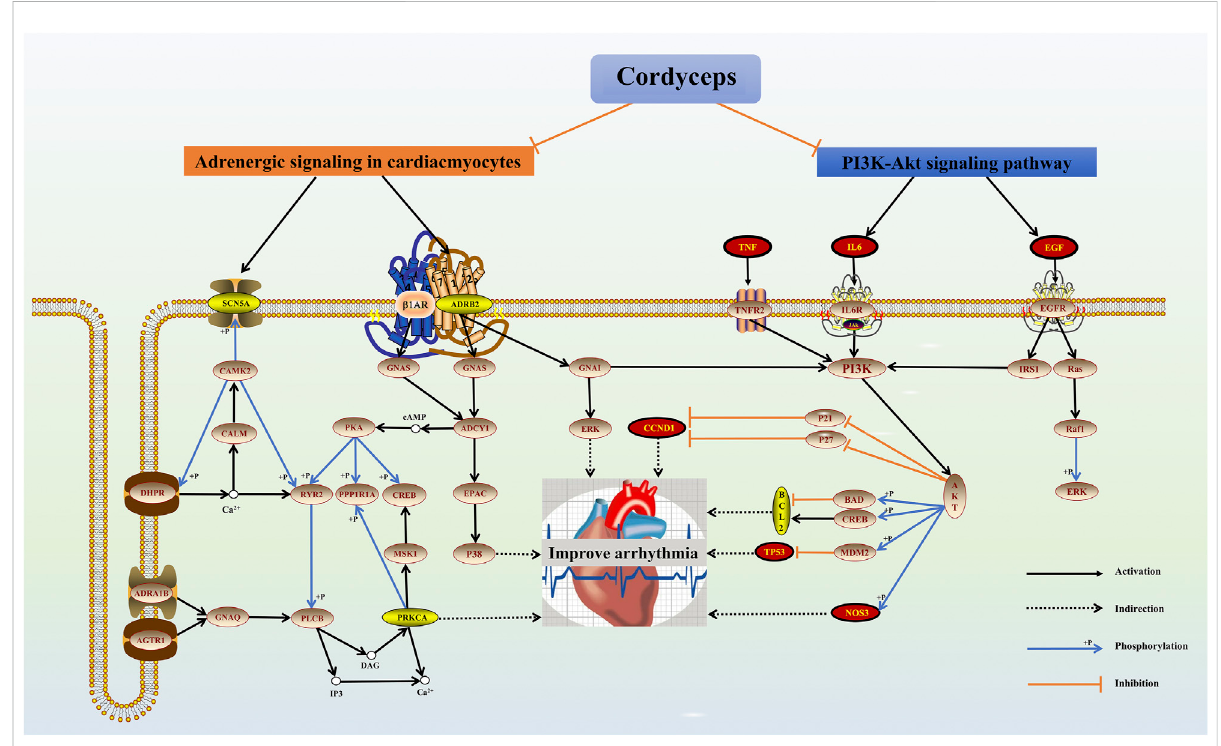
FIGURE 7 Mechanisms underlying theactionofCordyceps,atraditionalChinese medicineincardiacfunction improvement. Therednodesrepresentthe hub genes, the yellow nodes represent common genes, and the other nodes are the genes of the